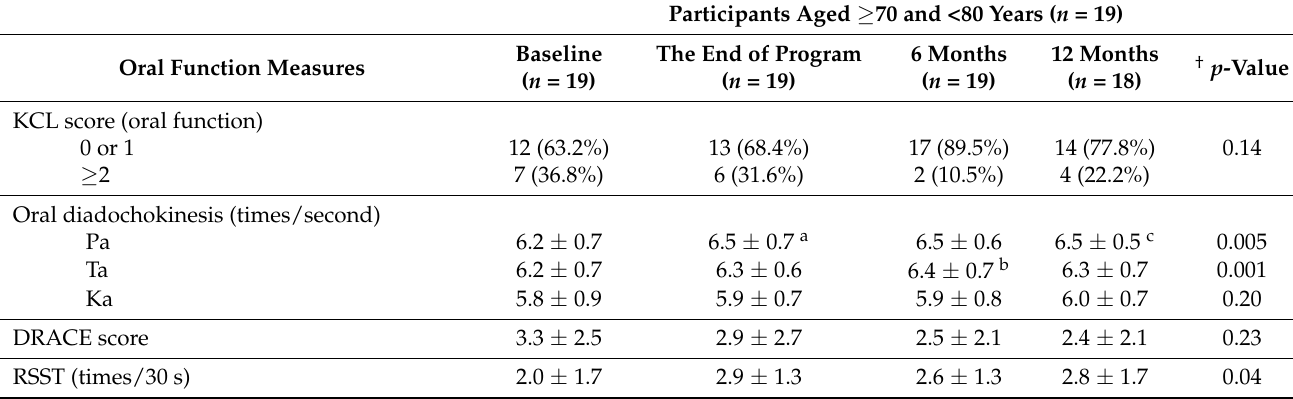
Table 4. Changes in oral function in participants aged ≥ 70 and <80 years.